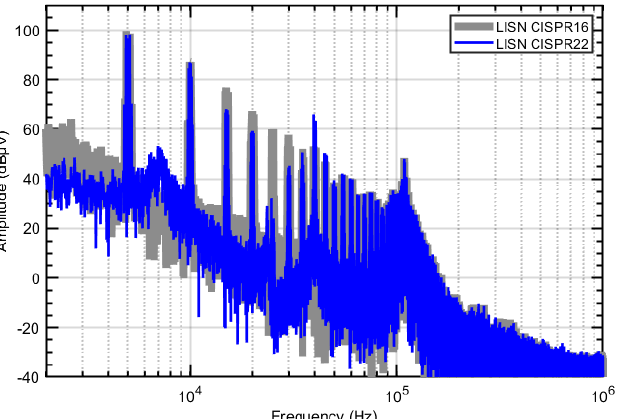
Figure 15. Conducted emissions (SPICE model) measured by using two different LISNs, i.e., CISPR16 (grey spectrum) and CISPR22 (blue spectrum).